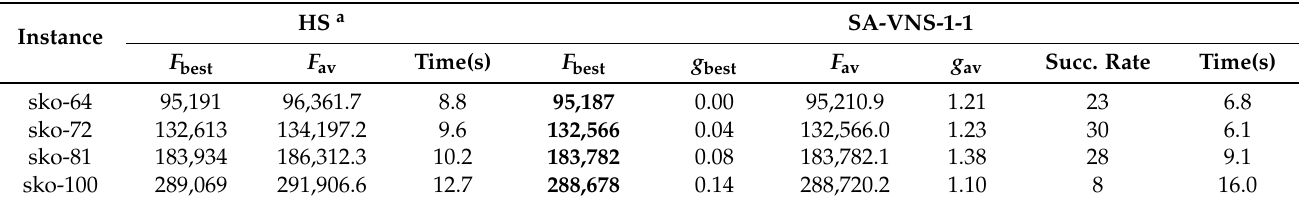
Table 7. Performance comparison for the sko instances of the tool indexing